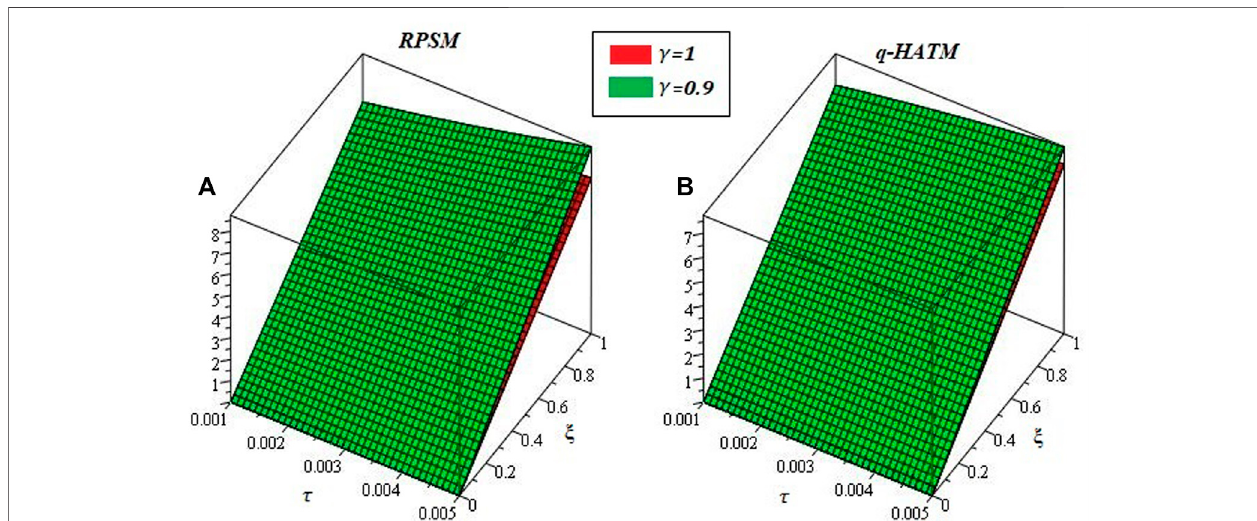
FIGURE 7 | 3D plots of (A) RPSM (B) Exact (C) q-HATM-solutions at δ = 1 of Example 4.3.